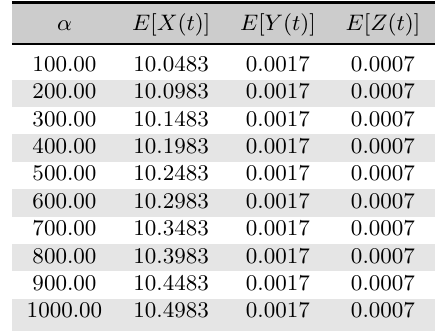
Table 3: E [ X ( t )] , E [ Y ( t )] and E [ Z ( t )] versus α for t = 0.50, λ = 0.20, µ =